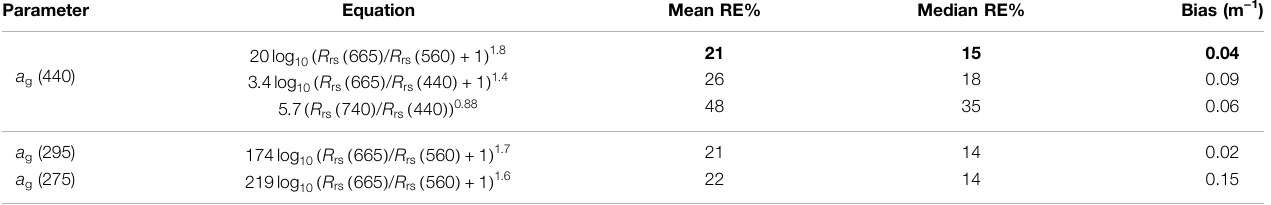
TABLE 1 | Algorithms to retrieve a g (440), a g (295) and a g (275), with associated performance metrics. Numbers in bold font highlight the best model. Parameter